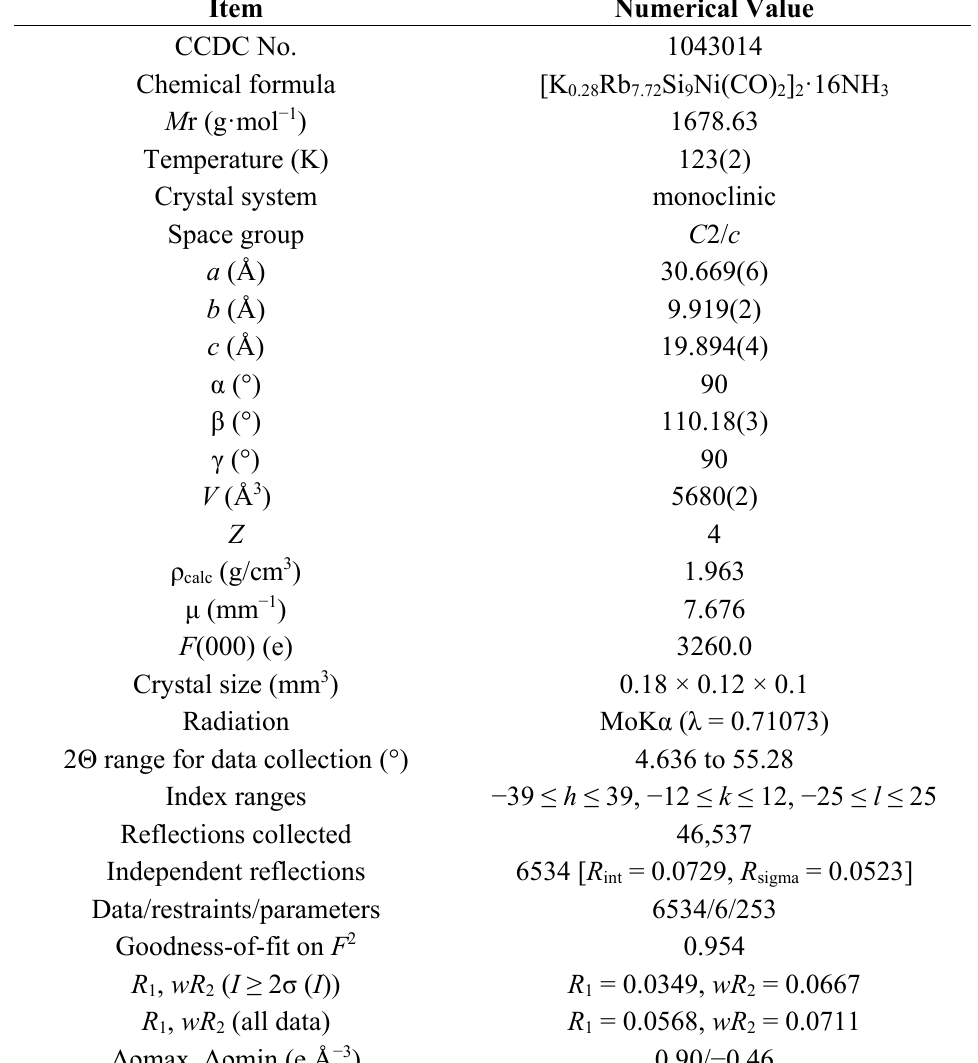
Table 1. Crystal data and structure refinement details for [K 0.28 Rb 7.72 Si 9 Ni(CO) 2 ] 2 ·16NH 3 ( 1